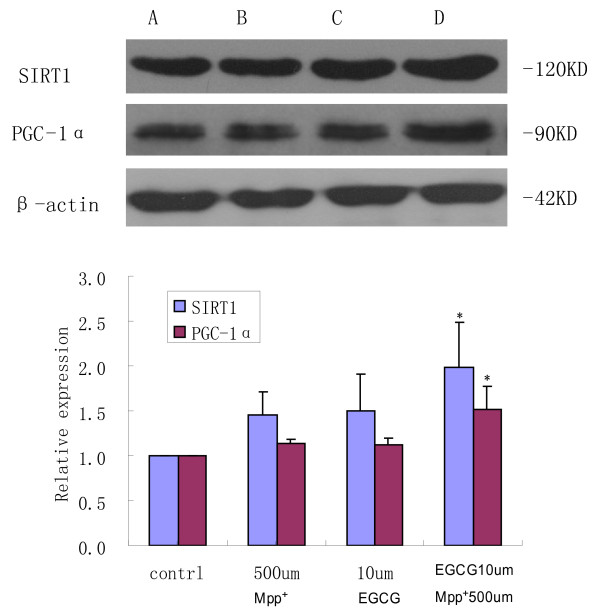
Effect of MPP+and EGCG on PGC-1α and SIRT1 protein expression in PC12 cells.(A) vehicle-only control, (B) MPP+ alone, MPP+ 500 μmol/L, (C) EGCG alone, 10 μmol/L EGCG, (D) 10 μmol/L EGCG + 500 μmol/L MPP+ (treatment with EGCG for 30 min, followed by MPP+ treatment). Results show that EGCG pretreatment could enhance PGC-1α and SIRT1 protein expression, and this up-regulation was higher than respective treatments with MPP+ and EGCG alone. β-actin was used as an internal reference. *P < 0.05 vs. vehicle-only control.